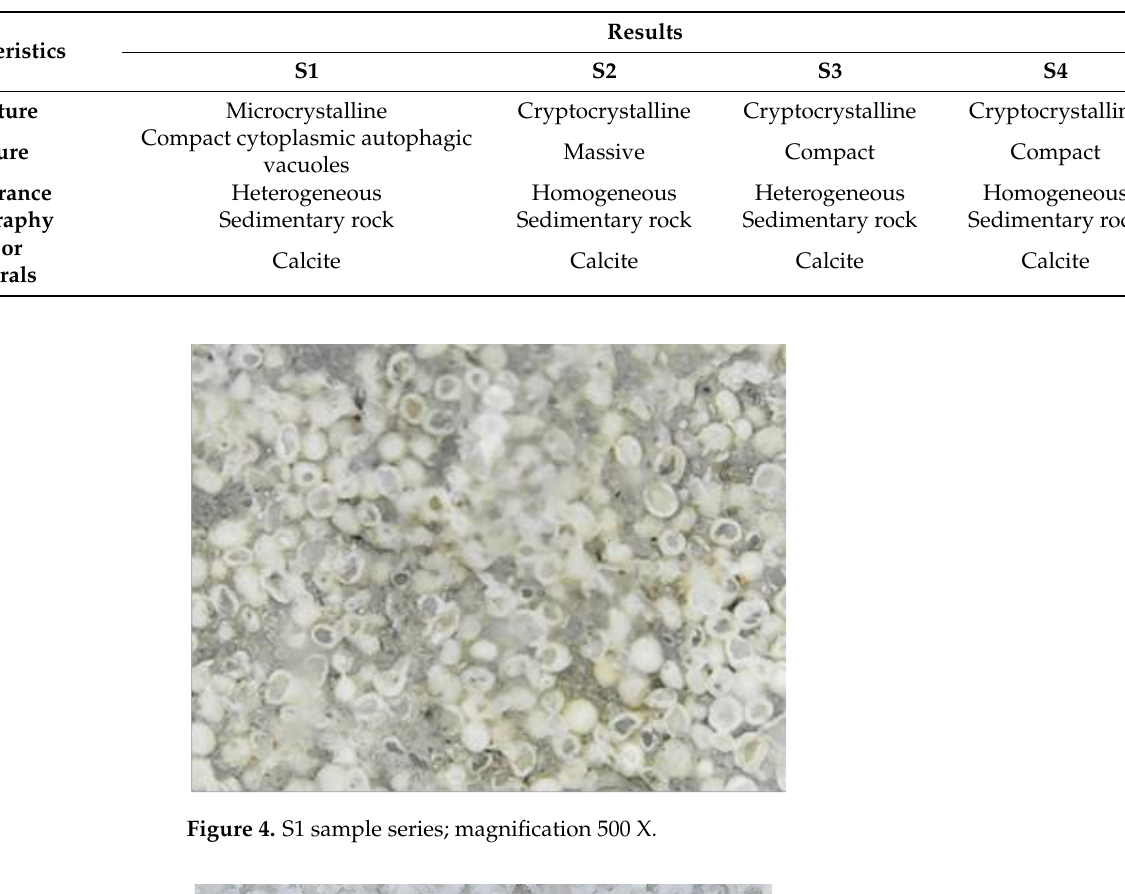
Table 1. The petrographic characteristics of the analyzed samples.